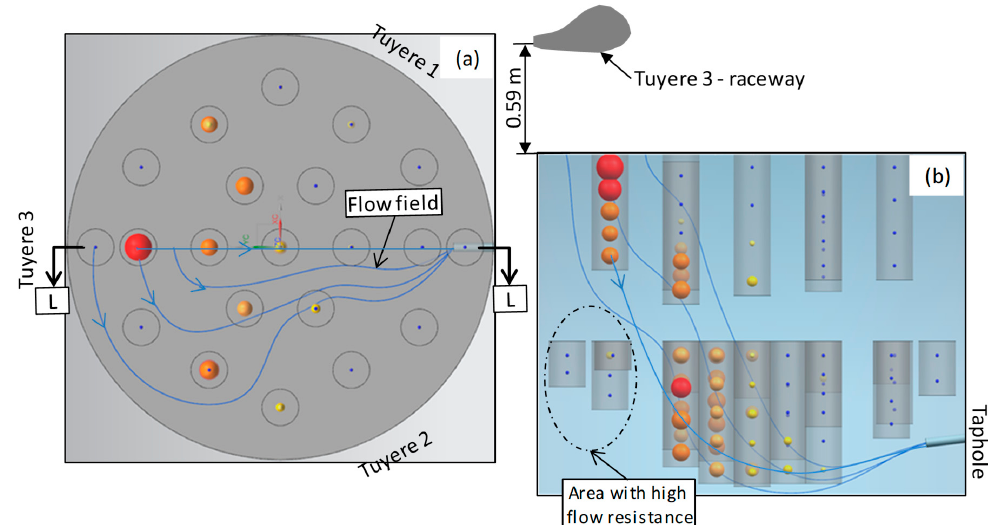
Figure 9. Interpreted 2 ‐ dimensional flow field of the hot metal in the hearth of the EBF based on the copper contents in collected metal samples: ( a ) top view; ( b ) side view. The size of the sphere indicates the relative content of the copper in the metal